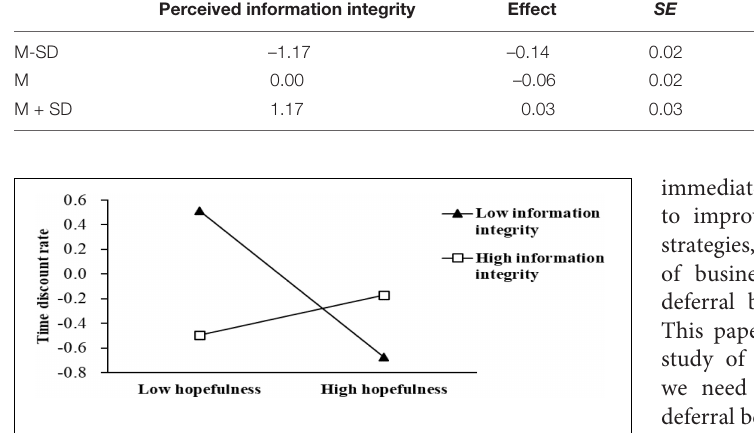
FIGURE 4 | Moderating effect